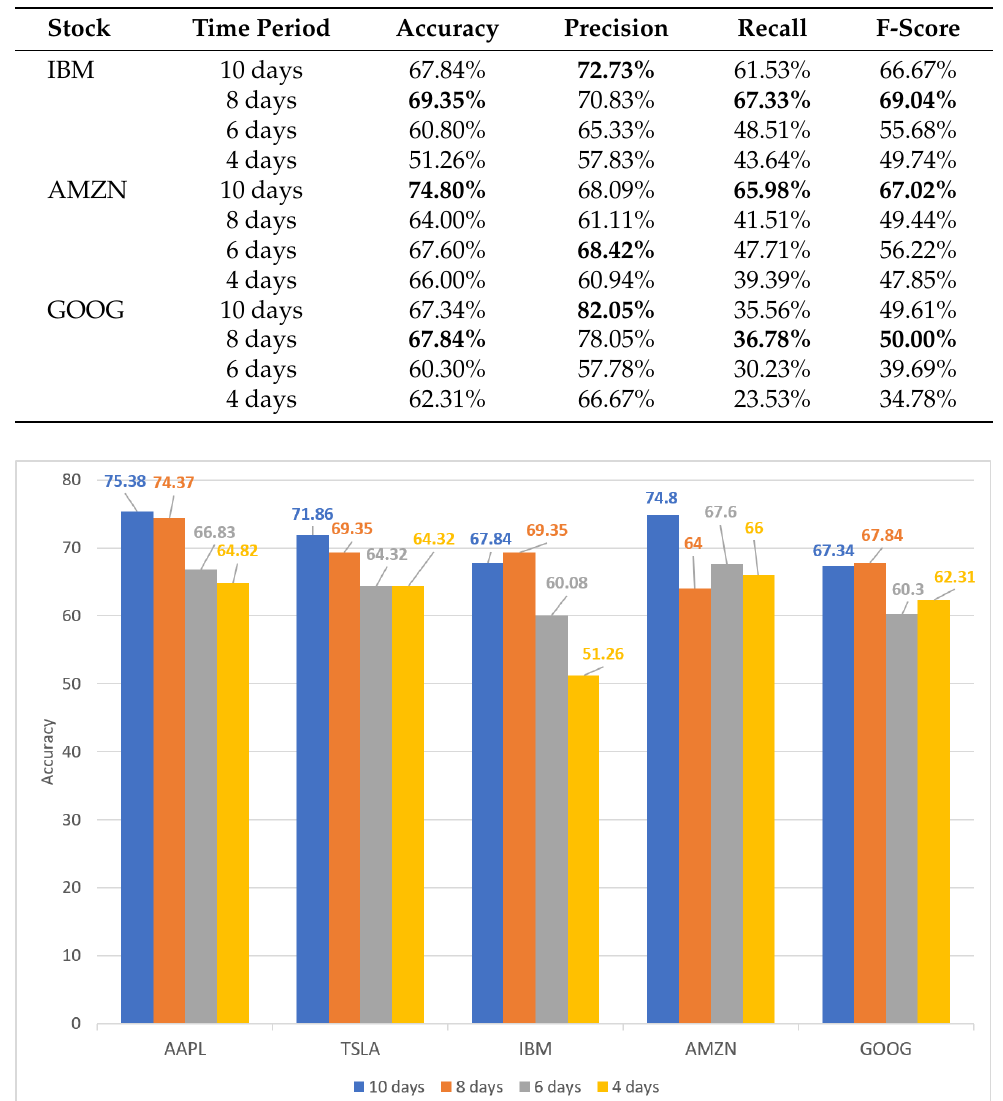
Figure 7. Performance of proposed method for five hot stocks (AAPL, TSLA, IBM, AMZN, and GOOG) on different period time (4, 6, 8, and 10